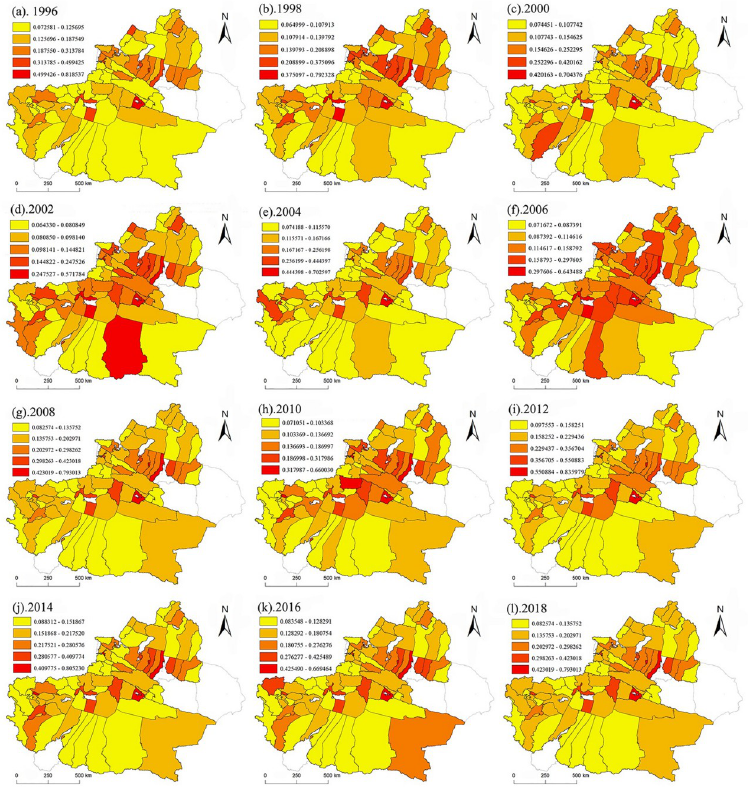
Fig 3. The distribution of comprehensive urbanization levels in XJC from 1996 to 2018. a The blank areas in the figure are cities and counties that are not included in this study.